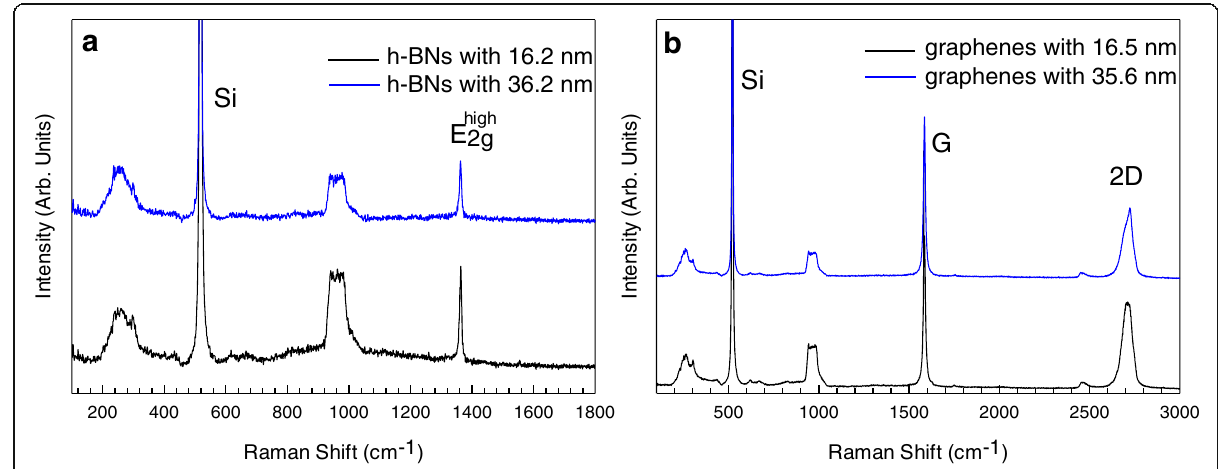
Fig. 2 a , b Raman spectra of h-BN and graphene flakes at room temperature. The blue curves are vertically shifted for Fig. 2. Second, with increasing temperature, E 2ghigh and G modes display a marked frequency downshift. The shifts of the E 2ghigh peak are − 18 and − 12 cm − 1 in 16.2 and 36.2 nm h-BN flakes respectively in the temperature from − 194 to 200 °C, whereas the shifts of G peak in two gra- phene flakes are smaller and remain below − 10 cm − 1 .